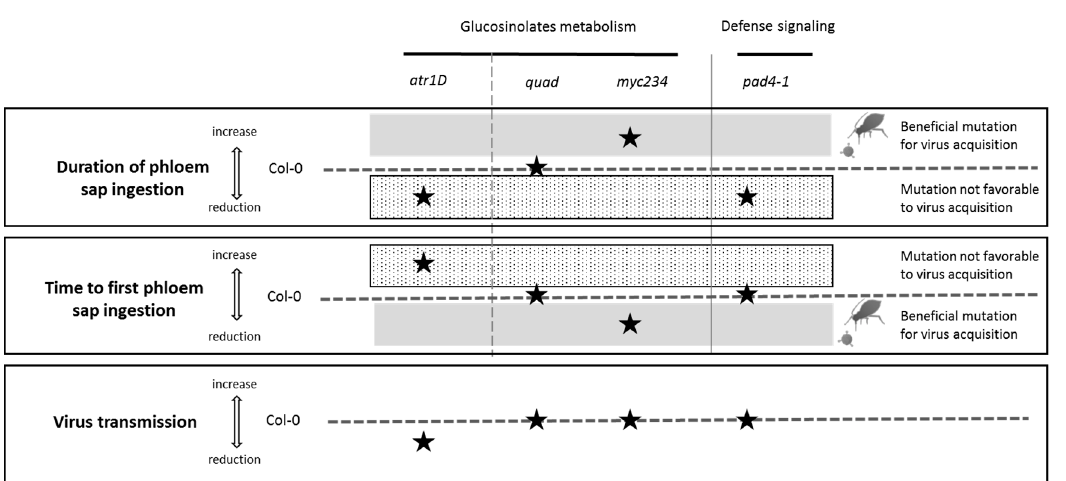
Table S5: TuYV titer measured by qRT-PCR in infected A. thaliana mutants quad , pad4-1 , and atr1D plants used as virus source in a virus transmission experiment (Exp. 4, Table 3).